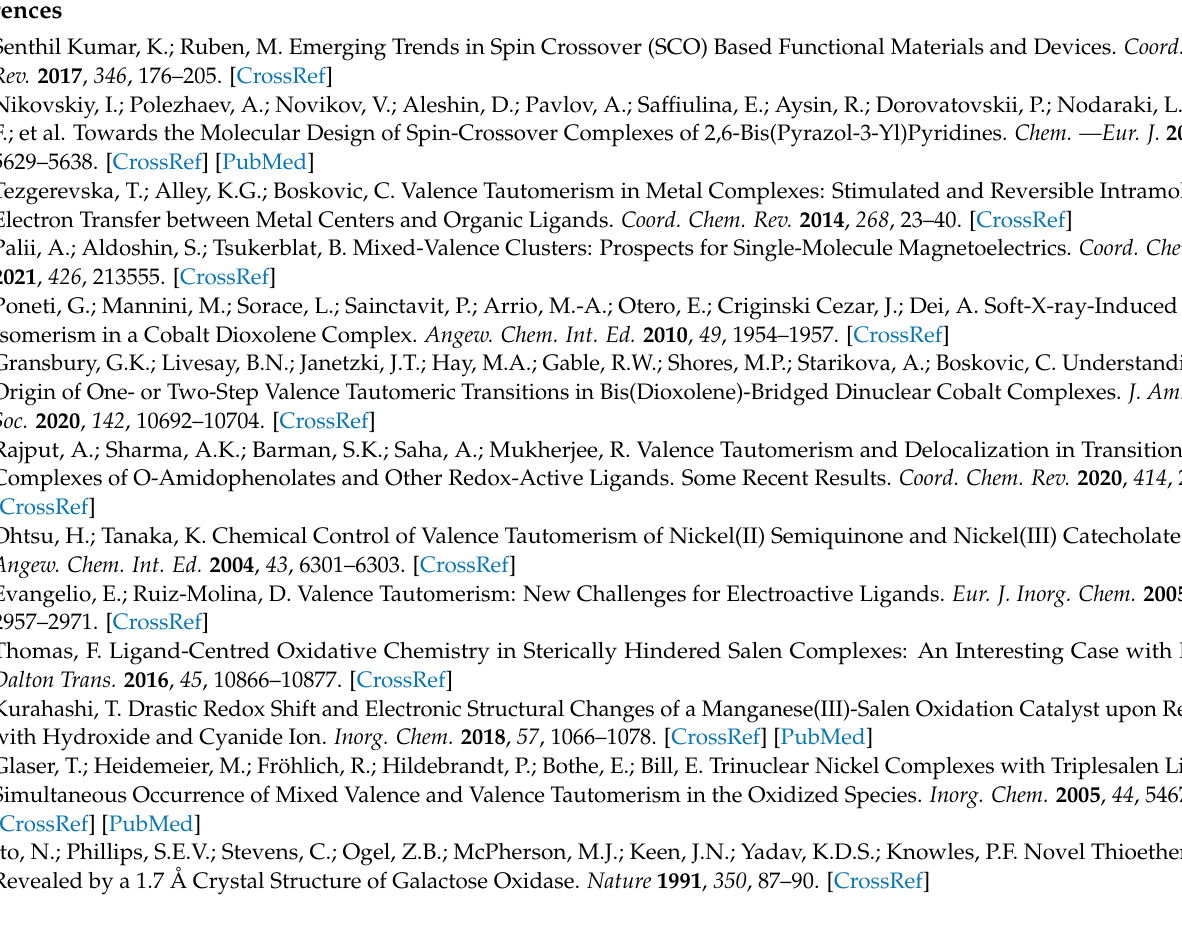
Figure S6: 1 H NMR spectra of [(phen) 4 Ni 2 (L)](Cl).; Figure S7: Variable-temperature magnetic suscep- tibility for a methanol solution of [(phen) 4 Ni 2 (L)](Cl) from the Evans technique. Figure S8: α -LUMO orbital (0.03 isosurface level) for [(bipy) 4 Ni 2 (L)] + (E LUMO = − 0.0887 a.u.).; Figure S9: α -LUMO orbital (0.03 isosurface level) for [(bipy) 4 Ni 2 (L)] 2+ (E LUMO = − 0.1007 a.u.).; Figure S10: α -HOMO orbital (0.03 isosurface level) for [(phen) 4 Ni 2 (L)] 2+ (EHOMO = − 0.1976 a.u.).; Figure S11: α -LUMO orbital (0.03 isosurface level) for [(phen) 4 Ni 2 (L)] 2+ (E LUMO = − 0.1008 a.u.).; Figure S12: Spin density (0.0065 isosurface level) for [(phen) 4 Ni 2 (L)] 2+